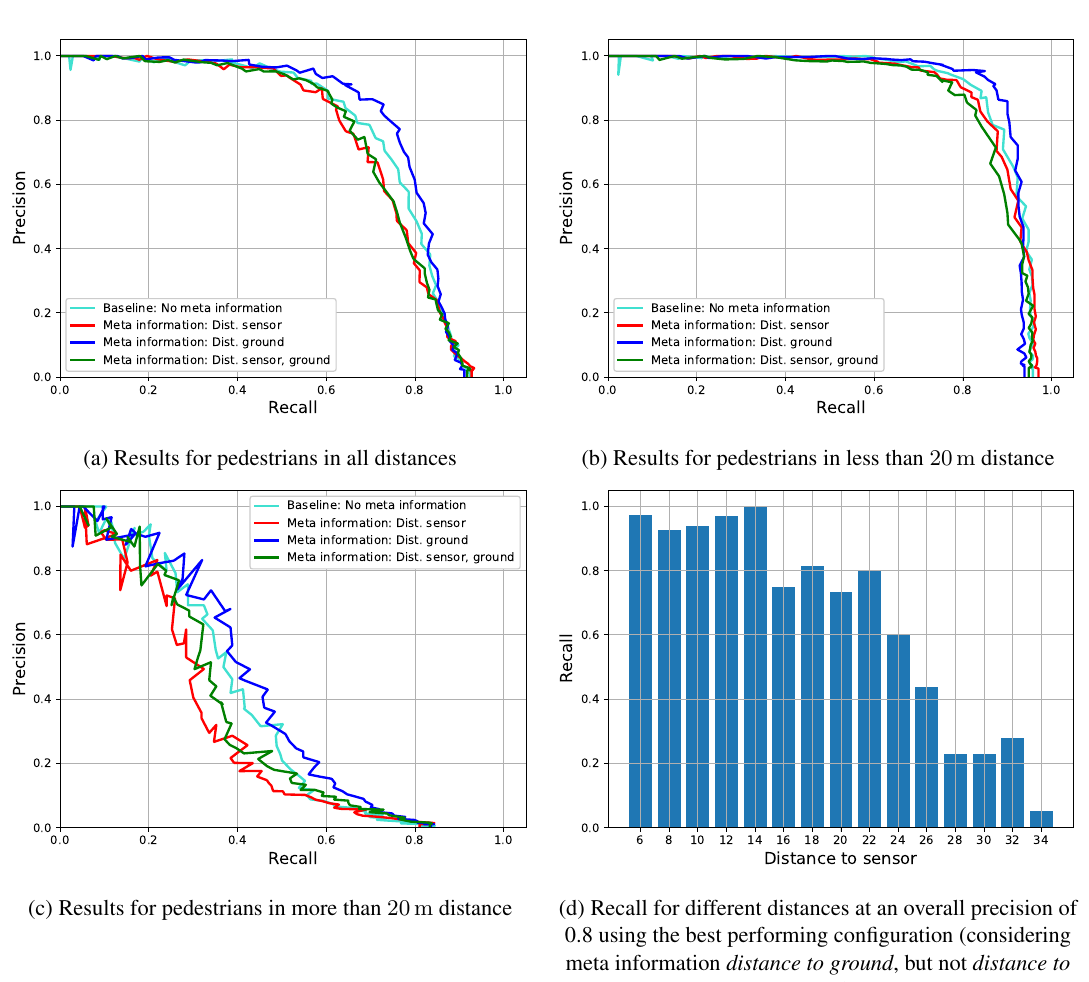
Figure 5. (a), (b), (c): Comparison of the four analyzed configurations for different distance intervals. (d) Analysis of the performance in different distances to the